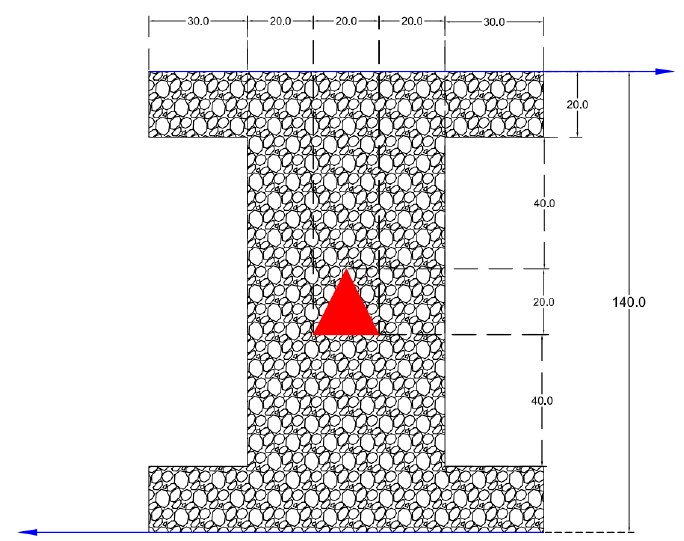
Figure 1. The problem geometry including a porous media with an internal hot block. All dimensions are in millimeters.